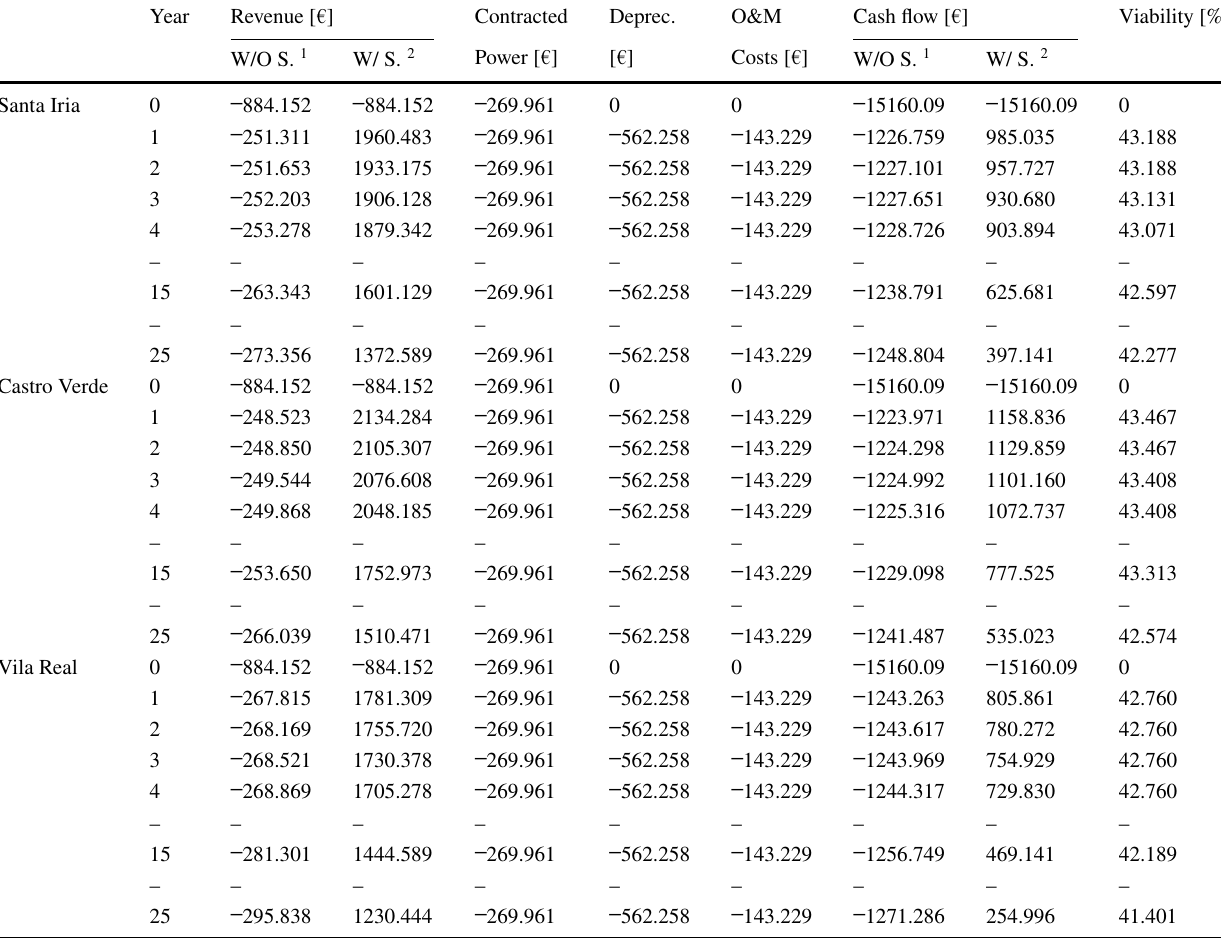
Table 10 c-Si NWs: Initial Investment = 14056.454 €: 1 Without selling the surplus energy to the grid; 2 With selling the surplus energy to the